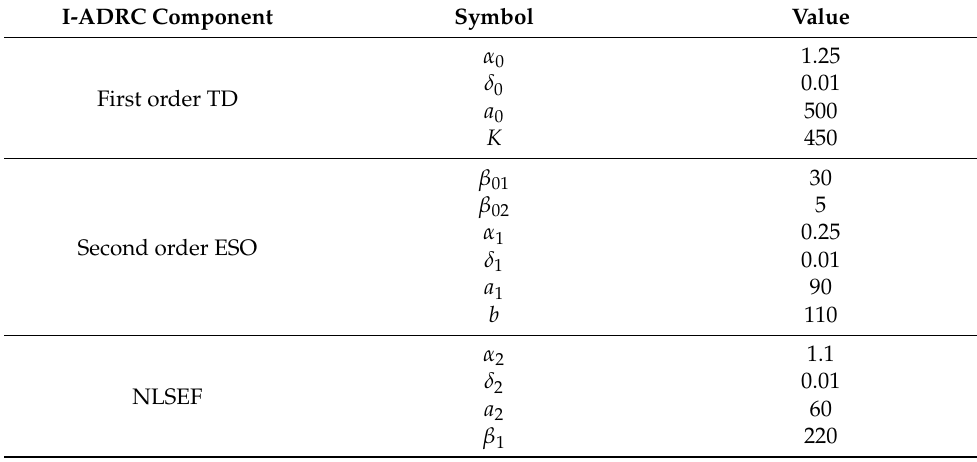
Table 2. I-ADRC parameter